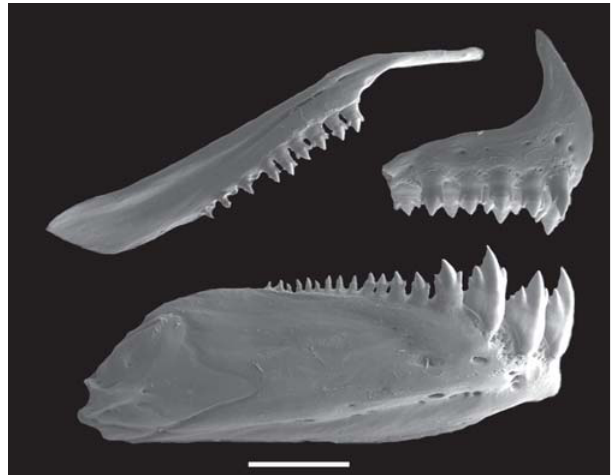
Fig. 24. Hemibrycon taeniurus , MCNG 8199, female, 57.5 mm SL. Scanning electron micrograph of right side upper and lower jaws. Scale bar = 1